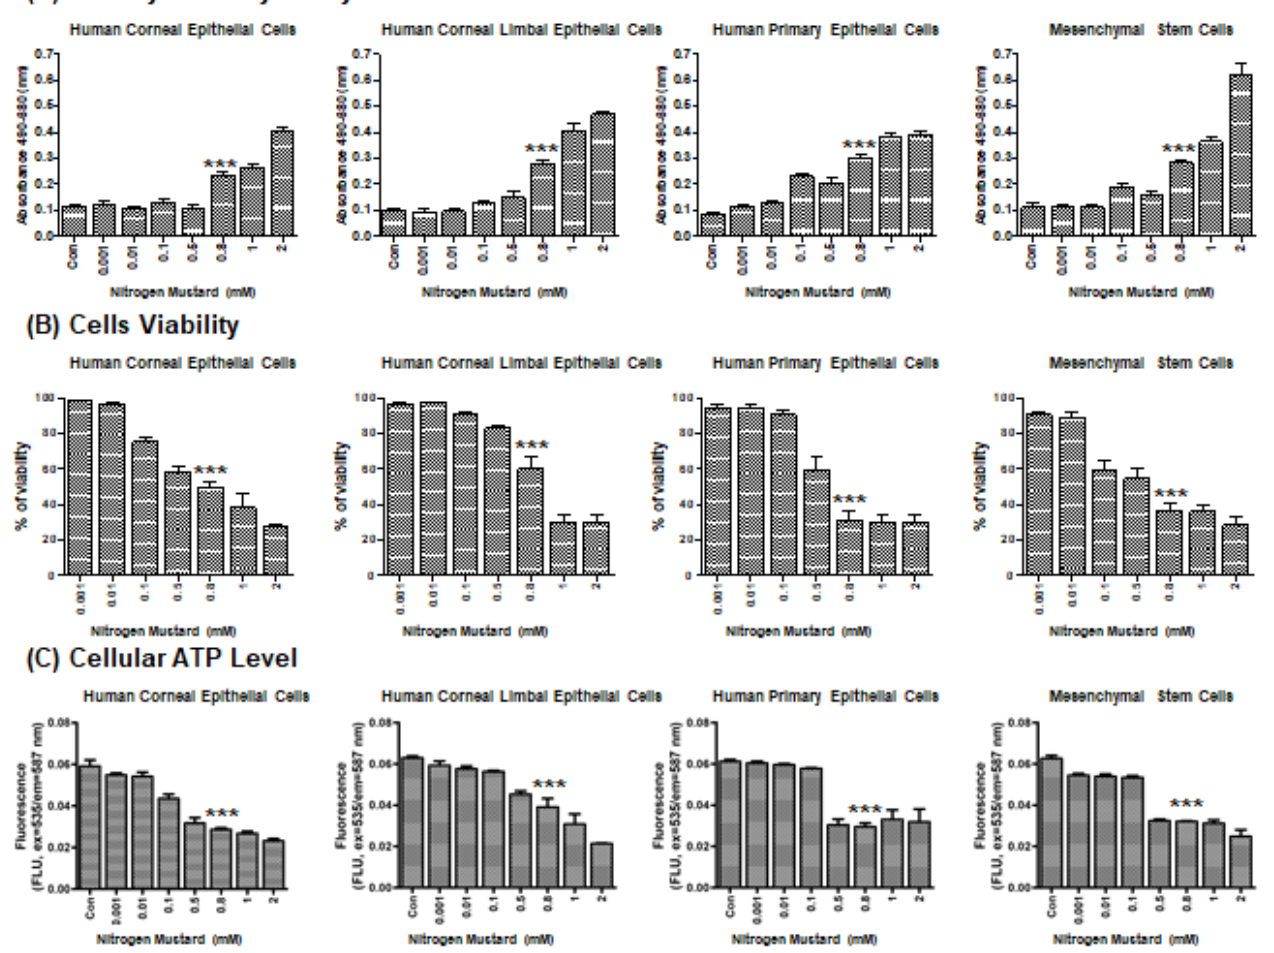
Figure 1. Effects of nitrogen mustard exposure on cell cytotoxicity, cell viability, and ATP level in culture cells. ( A ) Graph showing cytotoxicity for various doses of nitrogen mustard (NM) in culture cells as measured by LDH assay (n = 6/group). ( B ) Graph showing cell viability for various doses of NM in culture cells as measured by LDH assay (n = 6/group). ( C ) Graph showing ATP levels for various doses of NM in culture cells as measured by LDH assay (n = 6/group). *** p < 0.001 vs. untreated control or 0.001 mM NM treated group.